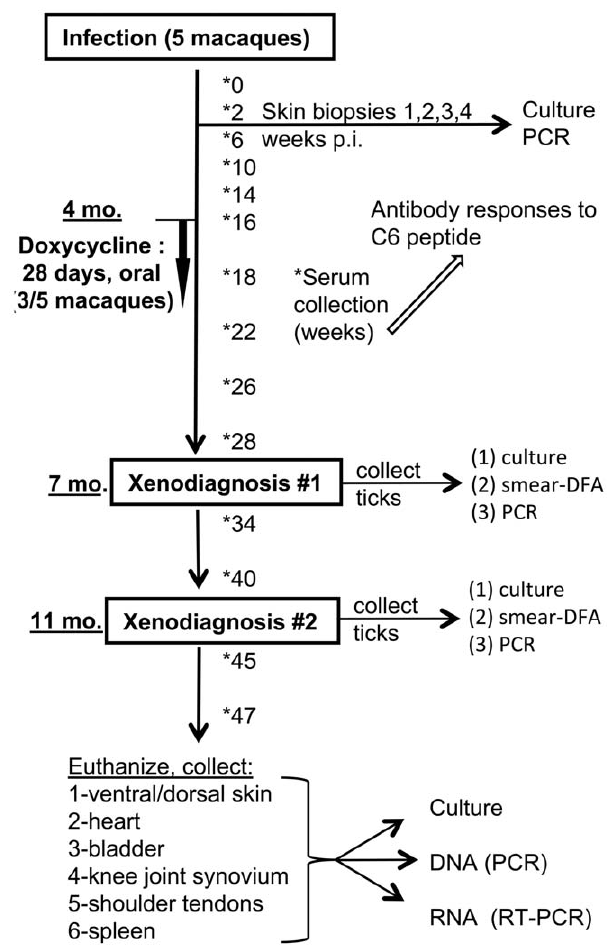
Figure 4. Experimental outline and sample collection for assessment of treatment efficacy in the disseminated phase of infection (Experiment 2). doi:10.1371/journal.pone.0029914.g004 detection by the ospC PCR method. The detection of B. burgdorferi nucleic acids by PCR was also performed on xenodiagnostic tick midgut samples (Figure 6B). For treated animal FK38, spirochetal DNA was detected by amplification of ospC from midgut contents when organisms were not detected by culture or DFA (Figure 6B).